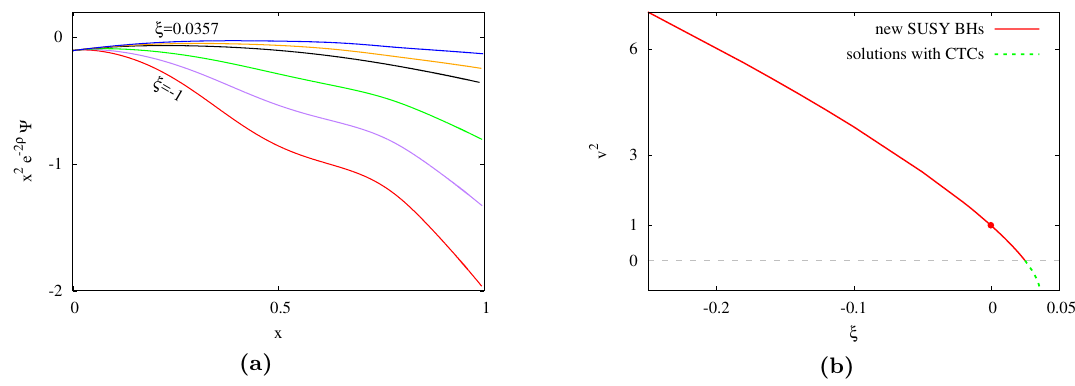
Figure 12. (a) Similar pro(cid:12)les for the function (cid:9) vs. the compacti(cid:12)ed radial coordinate x = (cid:26)= ( (cid:26) +1). (b) The squashing parameter v 2 as a function of the near-horizon parameter (cid:24) (cid:17) (cid:11) 4 . The red point marks the critical Gutowski-Reall solution from which the new susy black holes emerge. Note the existence a set of regular solutions with negative v 2 and closed timelike curves (dashed green line).